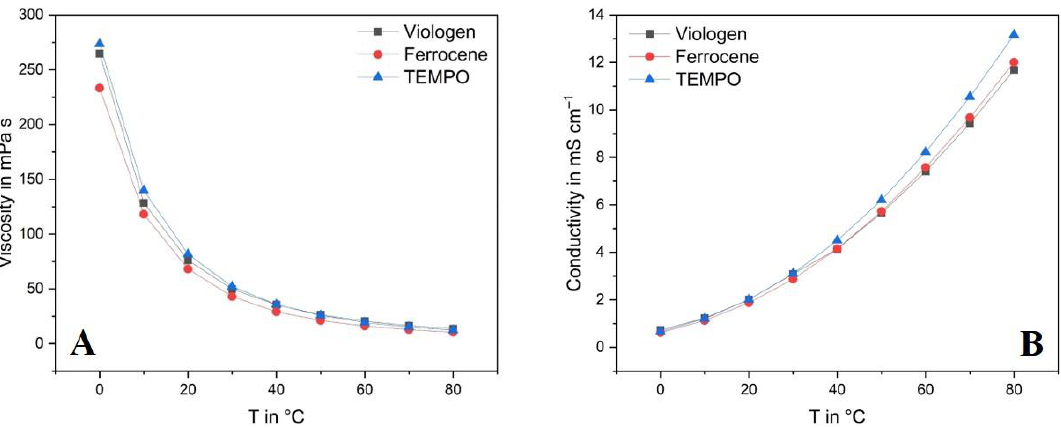
Figure 3. ( A ) Viscosity and ( B ) conductivity of 0.1 M RAIL-based electrolytes in Pyr 14 TFSI from 0 to 80 ◦ C. Initially, the mixtures were used in combination with AC-based electrodes (half-cell setup), and CV measurements (scan rate of 0.1 mV s −1 ) were performed in the voltage